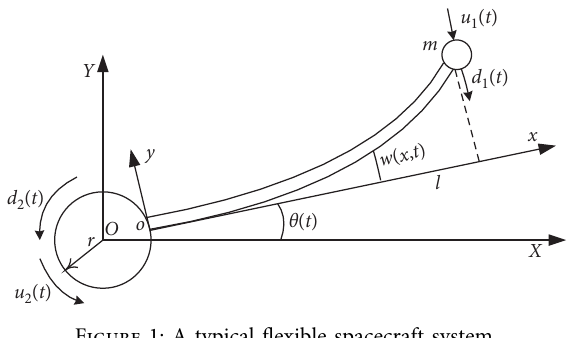
Figure 1: A typical flexible spacecraft